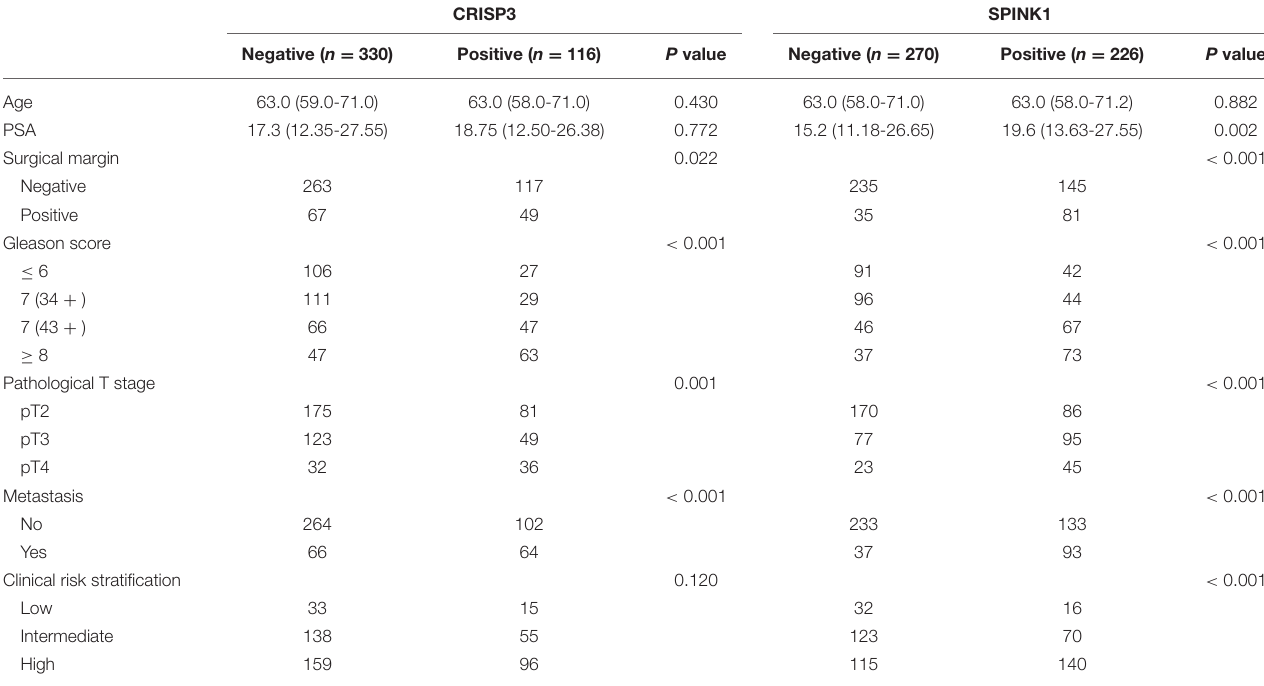
TABLE 2 | The association of CRISP3 and SPINK1 with clinical information of